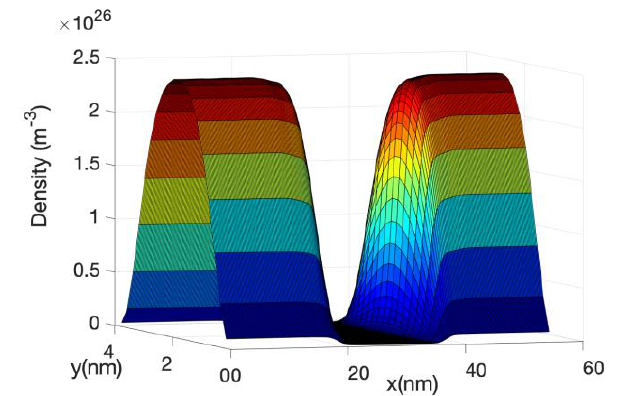
Figure 4. The electron density along the nanowire axis in a parallel xy plane at Vg = 0.4 V and Vd = 0.6 V. The figure shows the volume inversion and also the fulfilment of charge neutrality, see text.